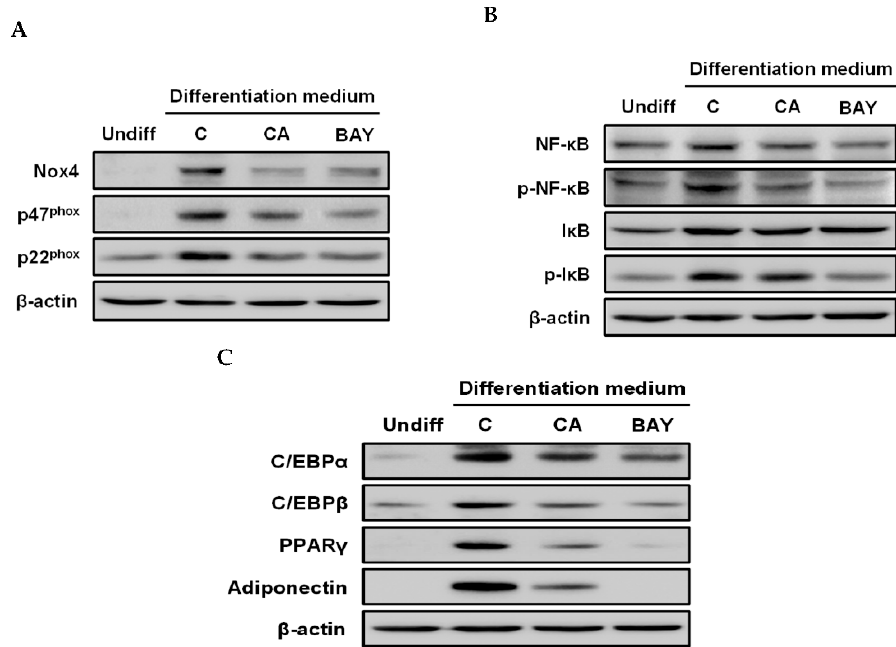
Figure 4. Effects of carnosic acid on the translation of Nox4 enzyme components, phosphorylation of NF- κ B and I κ B α , and translation of adipogenesis biomarkers in MDI-induced differentiation of 3T3-L1 pre-adipocytes to adipocytes for two days. ( A ) Translation levels of Nox4, p47 phox , and p22 phox by Western blotting analysis after differentiation for two days. ( B ) Translation and phosphorylation levels of NF- κ B and I κ B α by Western blotting analysis after differentiation for two days. ( C ) Translation levels of C/EBP α , C/EBP β , C/EBP γ , and adiponectin by Western blotting analysis after differentiation for two days. Data are presented as representative images of three independent experiments performed in triplicates). (Undiff; undifferentiated, which was not treated with MDI hormone mixture; C: control, which was treated with MDI hormone mixture; BAY: Bay11-7082).